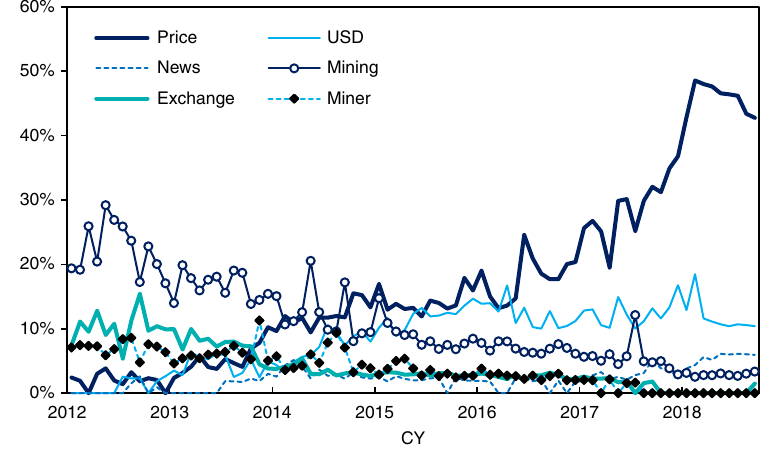
Figure 1. Google trends – words “ googled ” with the word “ Bitcoin